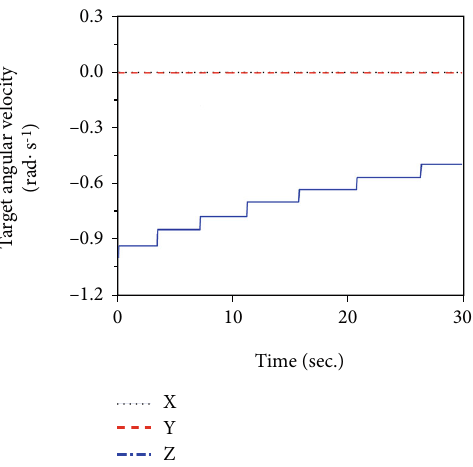
Figure 7: Collision forces. Figure 8: Target spin angular